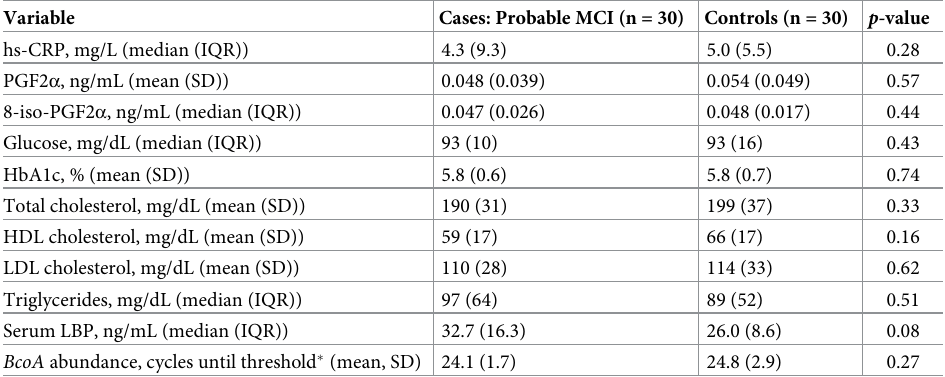
BcoA abundance, cycles until threshold � (mean, SD) 24.1 (1.7) � Lower values represent higher abundance. N = 30 for controls. N = 29 for cases as one case had missing data. p - values were determined for all continuous variables by a two-sample t-test, except for 8-iso-PGF2 α and glucose, for which the Wilcoxon Rank Sum test was used. p -values were determined for all categorical variables by a chi-squared test. Abbreviations: 8-iso-PGF2 α —8-iso-prostaglandin-F2 α ; BCoA—Butyryl-CoA; hb—hemoglobin; HDL—high density lipoprotein; hs-CRP—high sensitivity C-reactive protein; IQR—Interquartile Range; LBP— lipopolysaccharide binding protein; LDL—low density lipoprotein; MCI—mild cognitive impairment; MoCA— Montreal Cognitive Assessment; PGF2 α —prostaglandin-F2 α .; SD—Standard Deviation